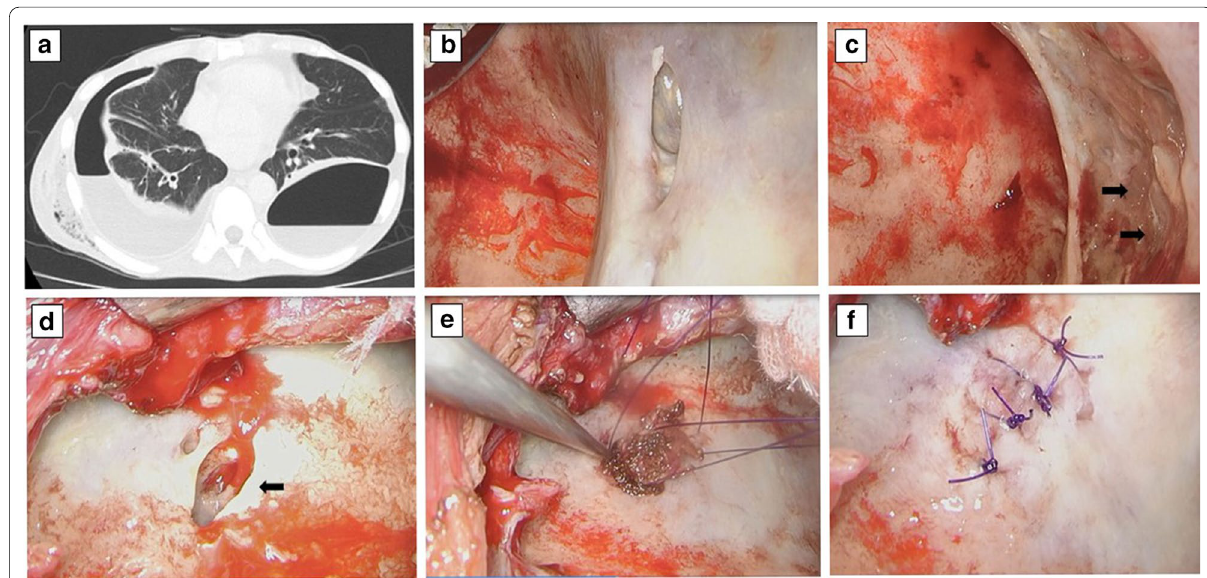
Fig. 1 a CT on admission showed bilateral pneumothorax and pleural effusion. The intraoperative findings at the first surgery are shown: b fistula in the right lateral segment (S 9 ), c fistula in the right posterior segment (S 10 ) (black arrow), d fistula in the left posterior basal segment (S 10 ) (black arrow), e free intercostal muscle flap plugged into the left fistula, f left S 10 fistula sutured after plugging with the free intercostal muscle